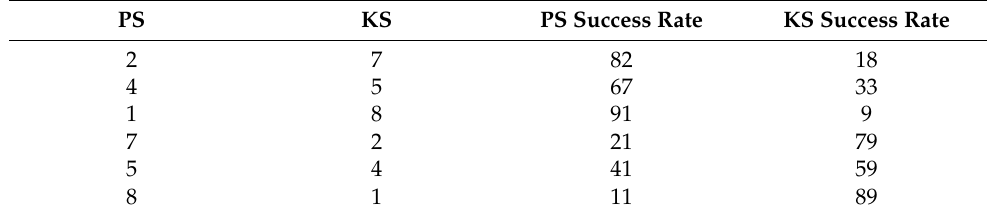
Table 4. PS and KS recognition success rate